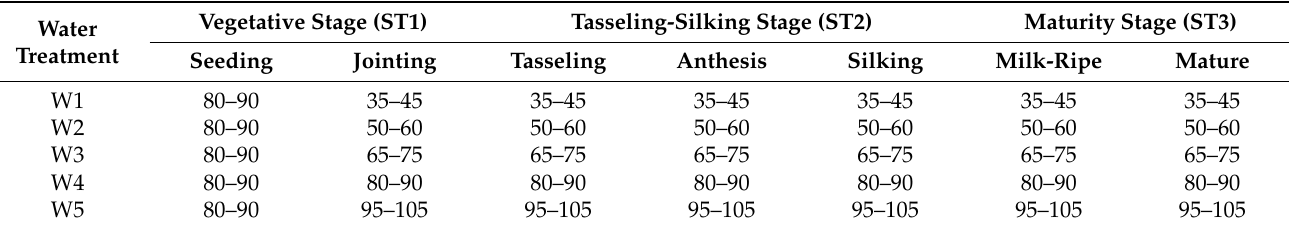
Figure 1. The water and fertilizer observation field of agrometeorological observation and experi- mental station of NUIST. In order to preserve and strengthen the seedlings, the water stress experiment began from the late jointing stage of the maize, and the soil water was irrigated to 80–90% of the Table 1. Irrigation scheme for maize growth period (FC, %). field capacity (FC). The water treatment was started five days after the jointing stage until the summer maize was harvested according to the percentage of FC, and there were three replicates for each treatment. Five continuous water treatment levels were set in the ex- periment, namely, W1 (severe drought stress, 35% to 45% FC), W2 (moderate drought stress, 50% to 60% FC), W3 (mild drought stress, 65% to 75% FC), W4 (CK, full water supply, 80% to 90% FC), and W5 (mild flooding, 95% to 105% FC). The specific irrigation scheme is shown in Table 1. Table 1. Irrigation scheme for maize growth period (FC, %).